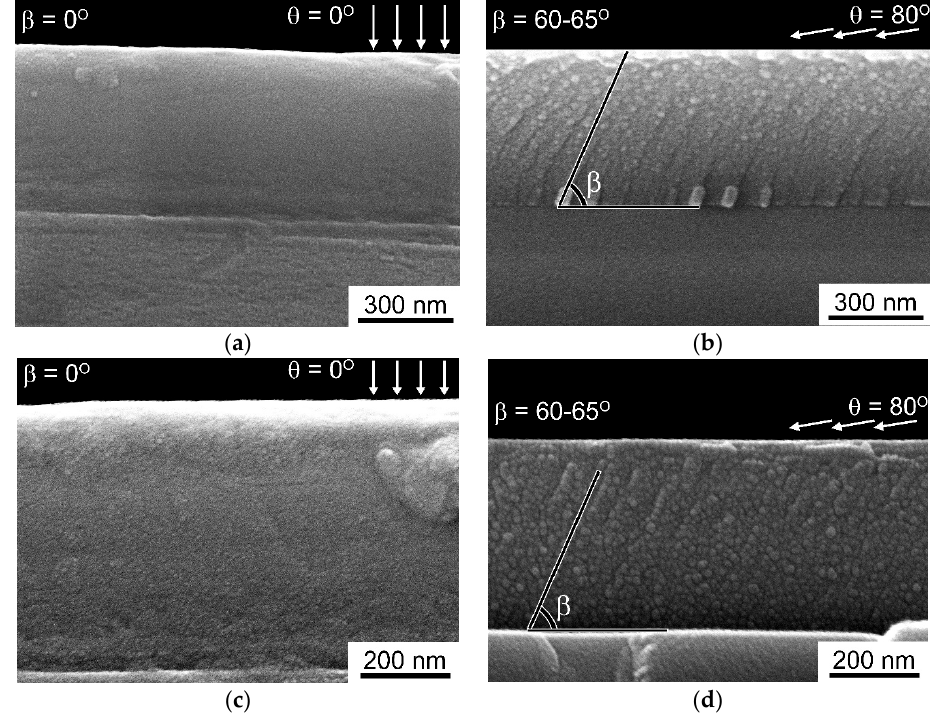
Figure 6. SEM cross-section images of obliquely deposited Zn-doped CaP thin films deposited on Si under tilt angles of 0° ( a ) and 80° ( b ) at 100000× magnification and films under tilt angles of 0° ( c ) and 80° ( d ) at 200000× magnification on Si substrates, demonstrating significant changes in the film morphology. The arrows indicate the angle of incidence θ . The columns are tilted by angle β .